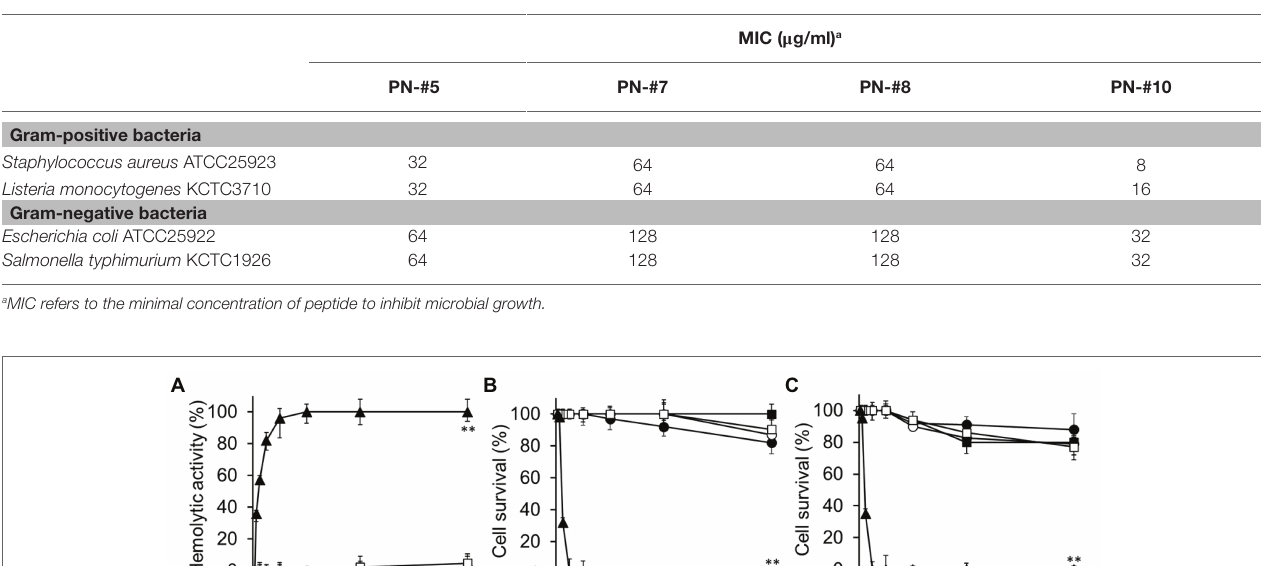
TABLE 2 | Antimicrobial activities of purified PN peptides.